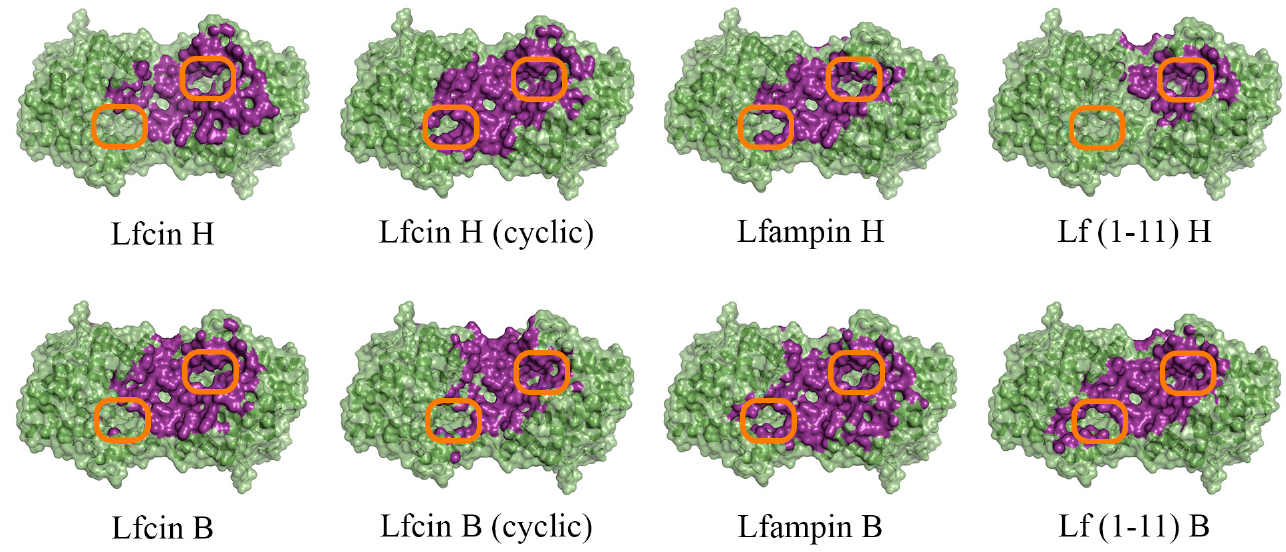
Figure 1. Front view of domains for binding of human (H) and bovine (B) lactoferrin-derived AMPs at pH 7.5 on the surface of His 6 -OPH homodimer (colored green). The atoms located within 4 Å of any AMP atom and the corresponding molecular surface are colored purple. The entrances to the active sites of His 6 -OPH dimer are highlighted with orange boxes.